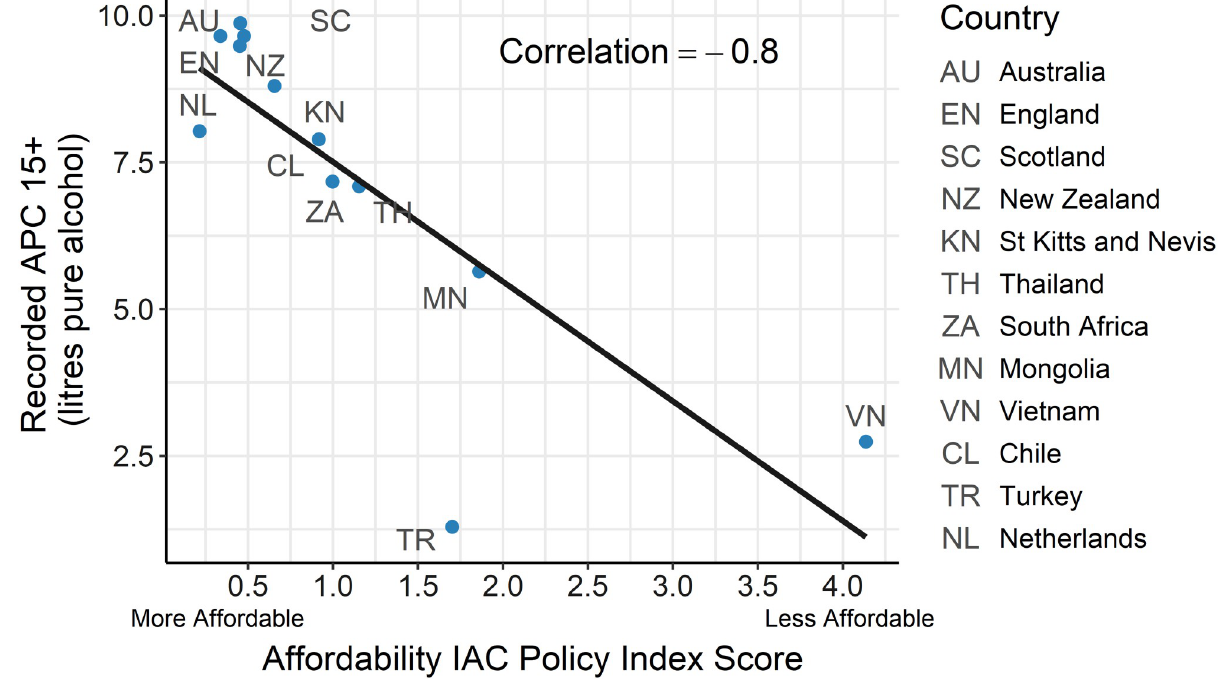
Fig 2. Relationship of affordability of commercial alcohol with recorded